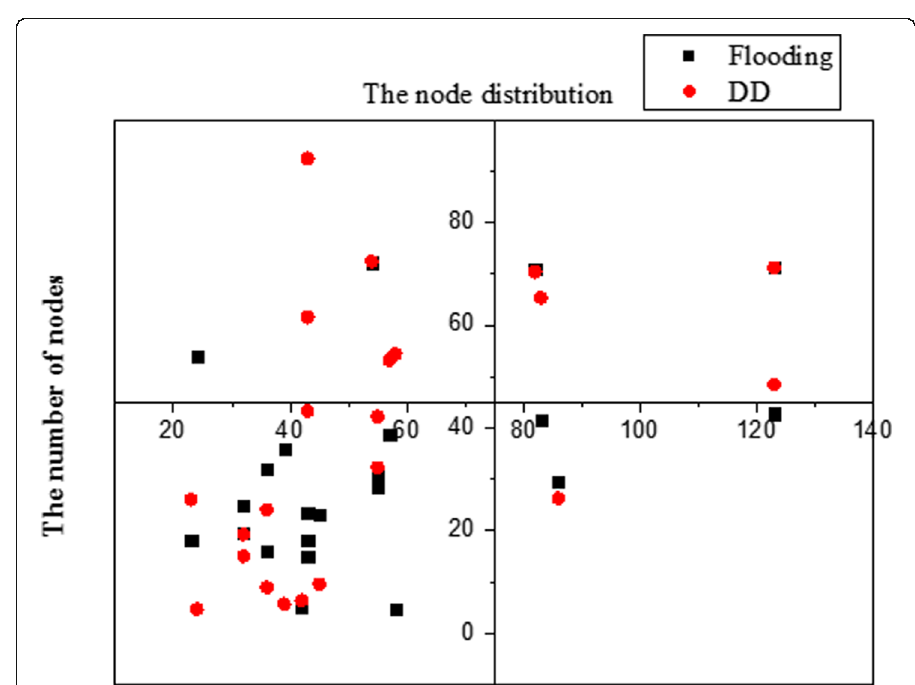
Fig. 2 Network node distribution